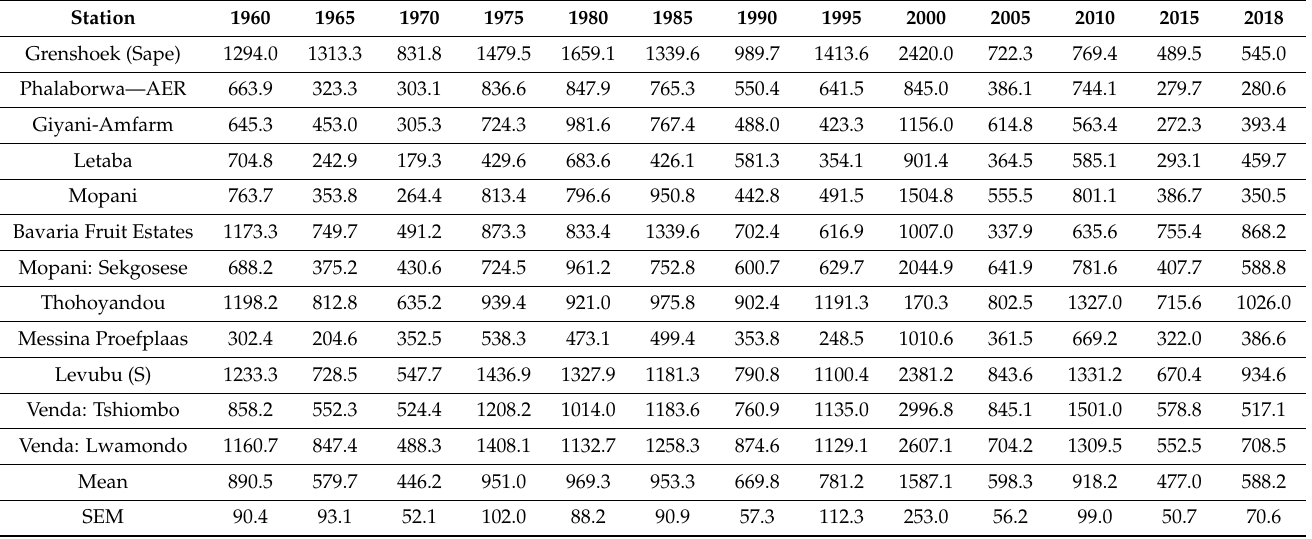
Table 1. The average annual rainfall in the Mopani and Vhembe